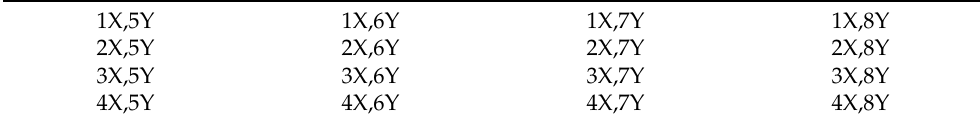
Table 2. Scheme of the positions of the TMA cations in the computational models; X and Y are positions of TMA cations; the numerals are the sequential numbers of the symmetry operation in the Wyckoff position 8 j .